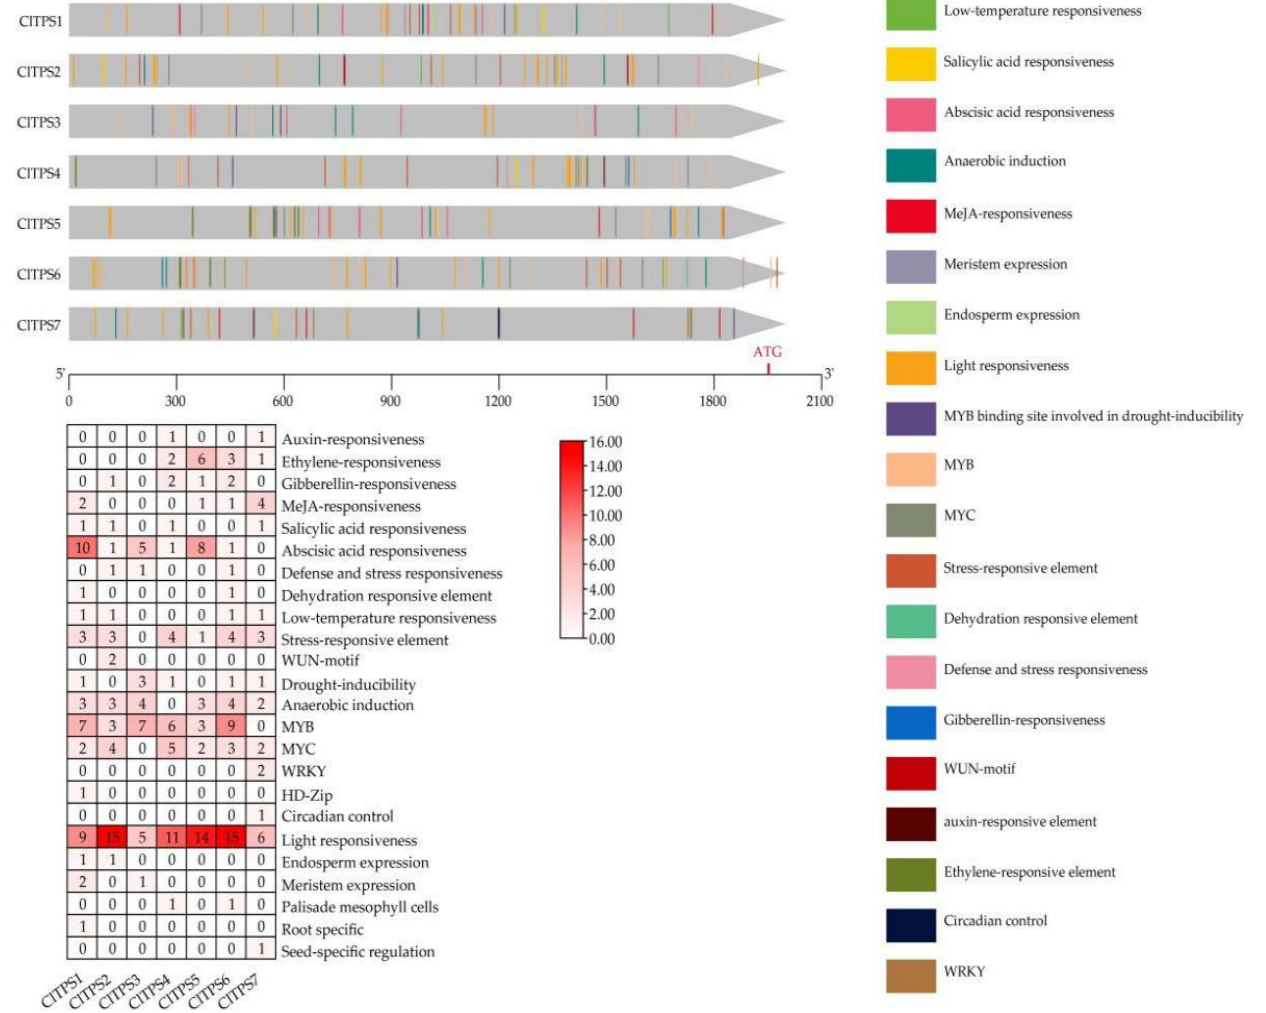
Figure 4. Cis-acting elements of ClTPSs. ( A ) Kind, quantity and position of cis-acting elements in ClTPSs; ( B ) numbers of cis-acting elements. ClTPSs; ( B ) numbers of cis-acting